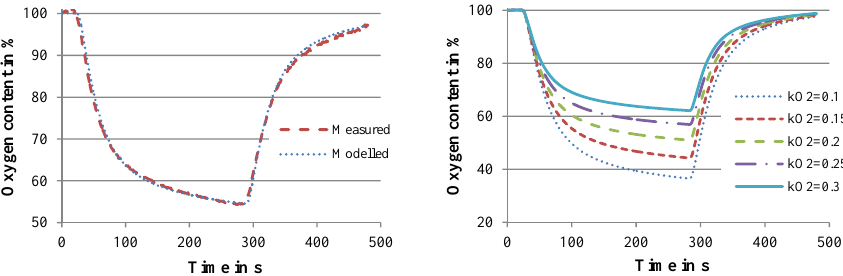
Fig. 7: left: Comparison between modelled and measured oxygen content for deoxygenation with nitrogen and oxygenation with compressed air; right: Impact of pump oxygenation coefficient on oxygenation-deoxygenation behaviour (calculated)